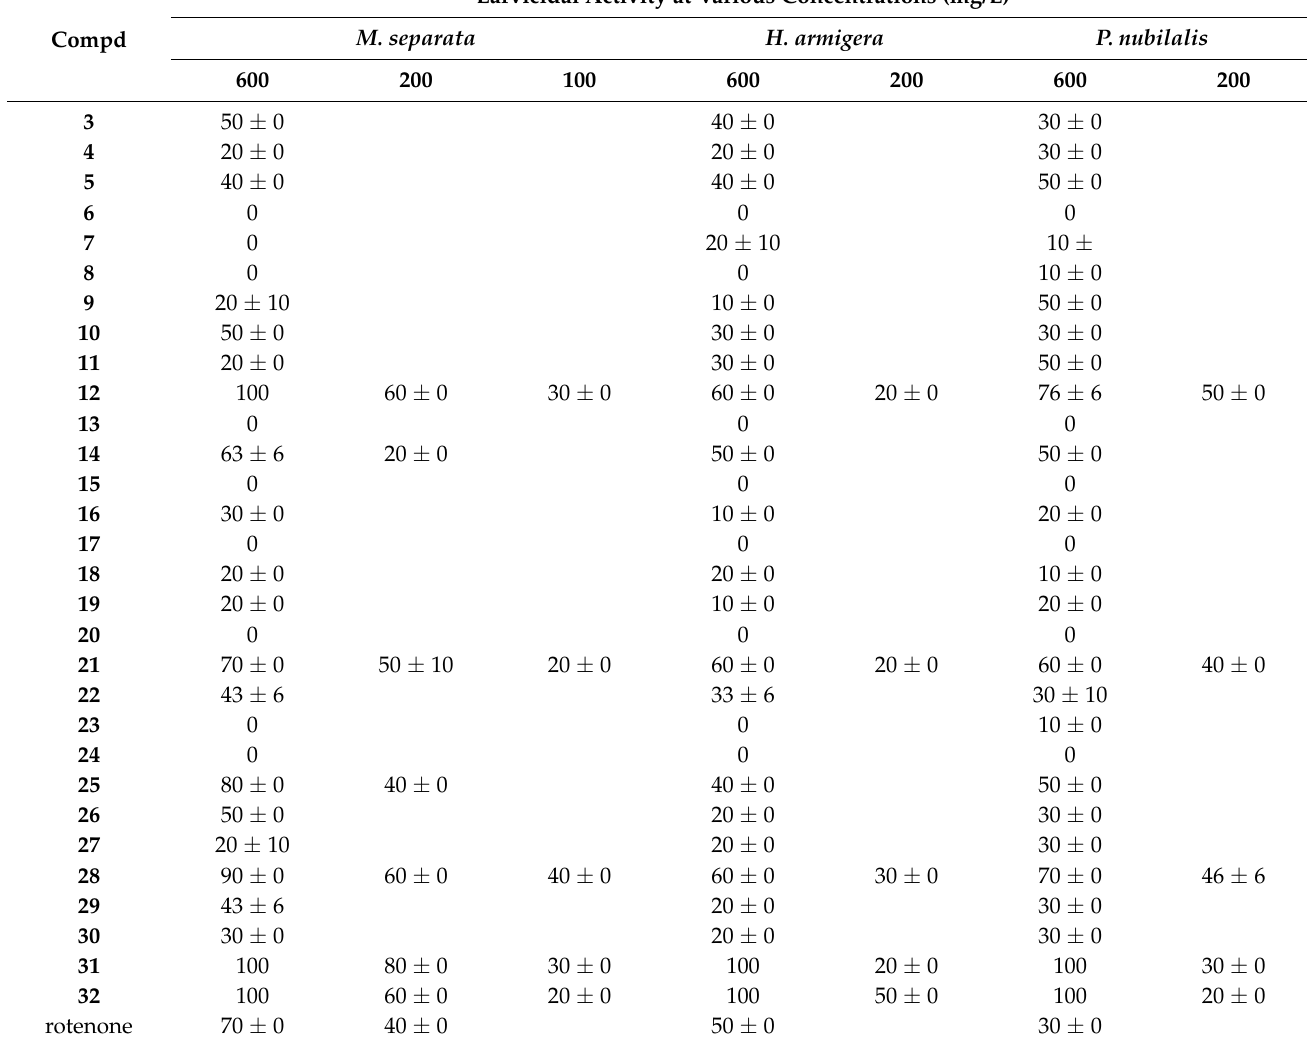
Table 5. Larvicidal activities of compounds 3 – 32 against Mythimna separate , Helicoverpa armigera , and Pyrausta nubilalis